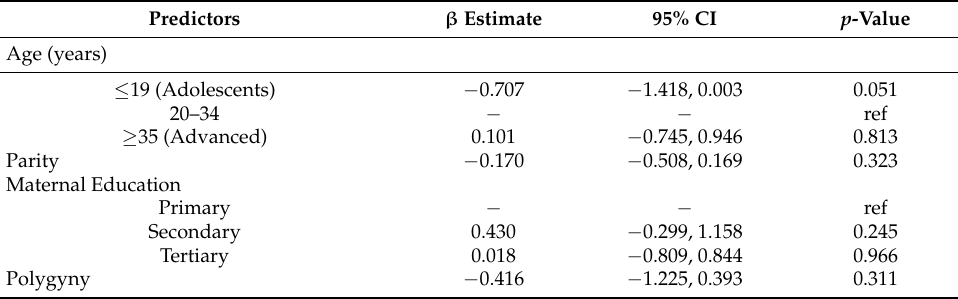
Table A7. Results of multivariate regression analysis for